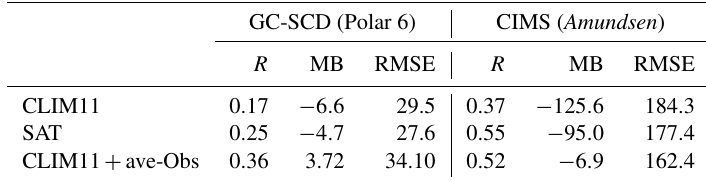
Table 2. Mean bias (MB), root-mean-square errors (RMSEs) and Pearson correlation coefficient ( R ) for model simulations (CLIM11, SAT and CLIM11 + ave-Obs) and observation results (GC-SCD and CIMS onboard the Polar 6 and Amundsen